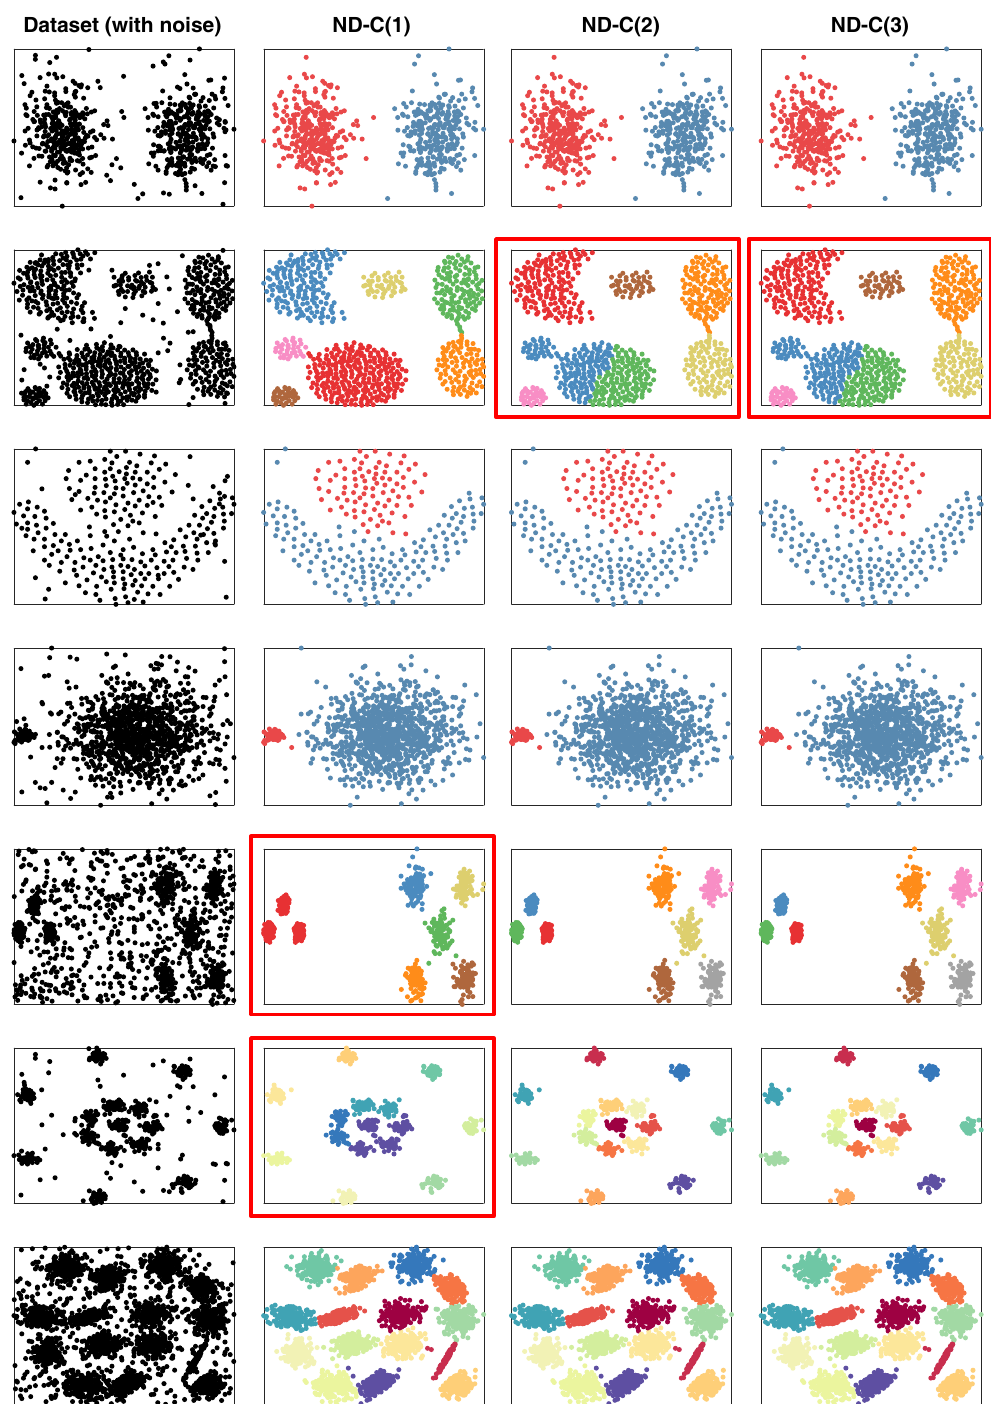
Figure 6. Comparison of clustering performance of ND-C(1), ND-C(2), and ND-C(3) on noise- contaminated datasets. The subplots within the red rectangles are the ones containing obvious false assignments. In each subplot (in columns 2, 3, and 4), different colors on points indicate different clustering assignments on